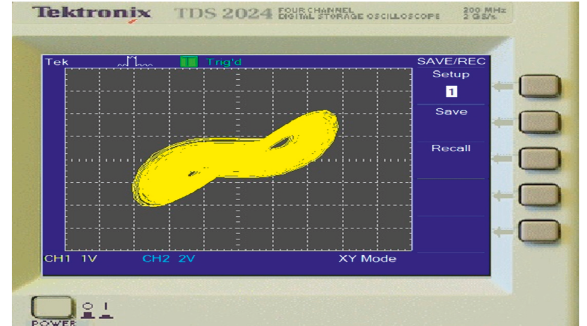
Figure 30: Electronic circuit simulation using MultiSim 14.0 for the new hyperchaotic two-scroll circuit (42) in the ( Z ordinate plane.